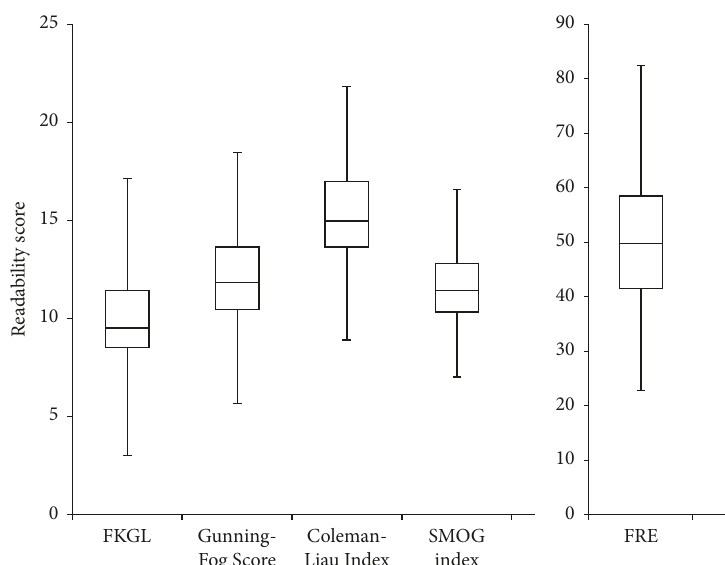
Figure 1: Box-and-whisker plots showing median readability scores of health information websites ( 𝑛 = 70 ; 𝑝 < 0.05 ).